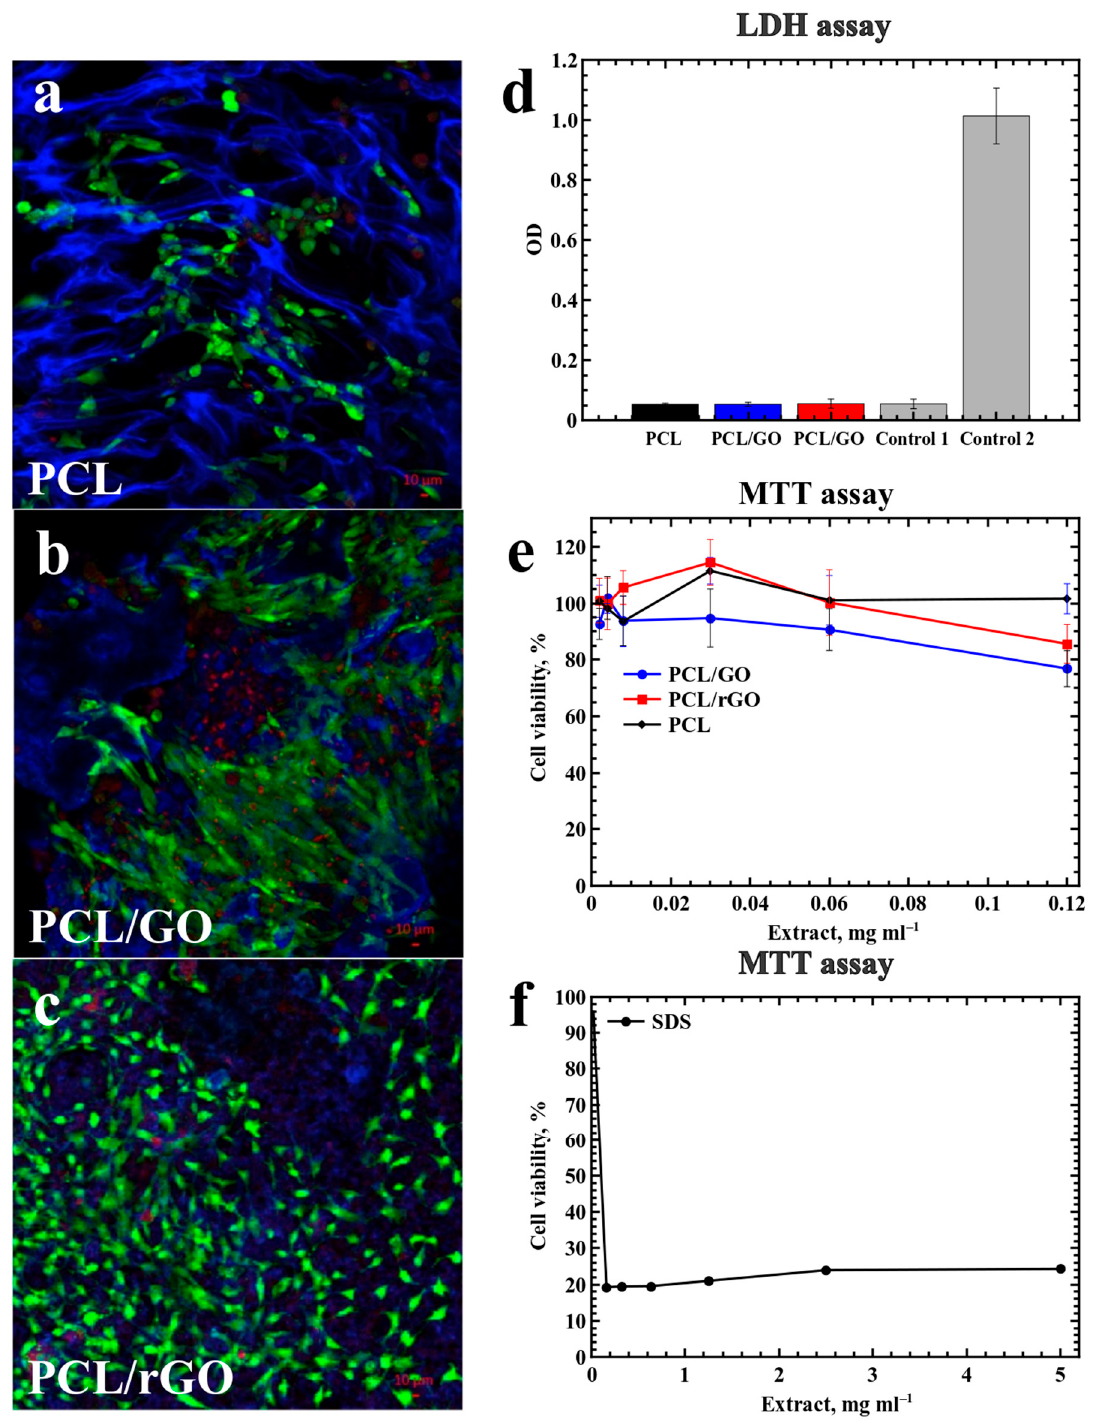
Figure 7. Cytotoxicity of PCL, PCL/GO, and PCL/rGO scaffolds. ( a – c ) Live/Dead staining (live cells—green (Calcein AM), dead cells—red (propidium iodide), scaffold—blue), laser scanning confocal microscopy. ( d ) lactate dehydrogenase release (LDH assay): Control 1—spontaneous LDH release as a negative control; Control 2—maximum LDH release (cell lysate) as a positive control. ( e , f ) Cell viability (MTT assay): Sodium Dodecyl Sulfate (SDS) as a positive control. The PCL, PCL/GO, PCL/rGO samples with 1% of GO content were chosen for the biocompatibility studies. The biocompatibility estimation of cells co-cultured with the PCL, PCL/GO and PCL/rGO scaffolds demonstrated that cells remained viable. When fragmented material was placed into a flask with a cell monolayer, the cells did not detach and were able to proliferate.